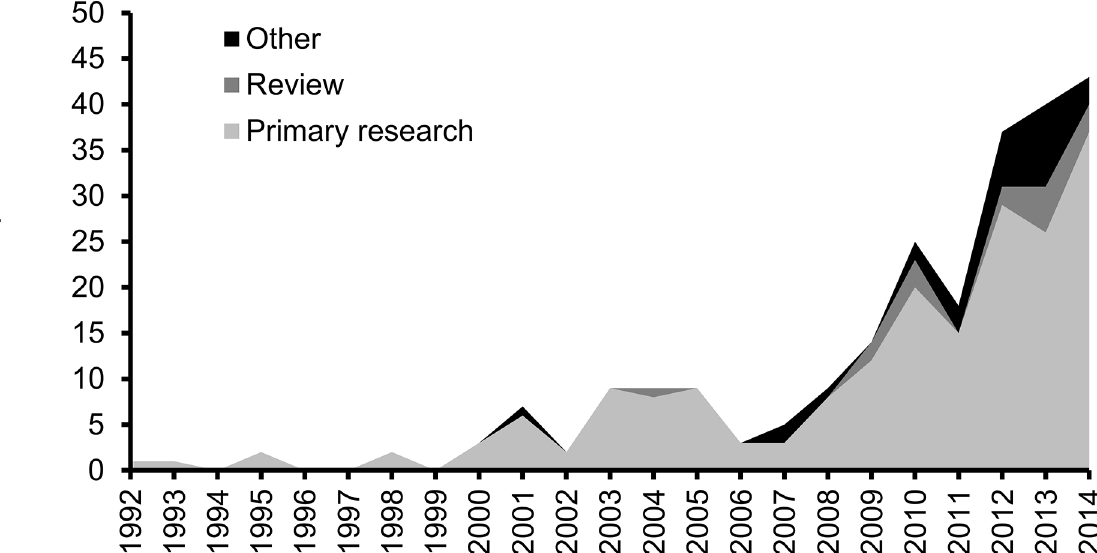
Fig 2. Development of research on the effect of neonicotinoids on bees over time. The single meta-analysis study was published in 2011 [12] and is not included in this figure. Data for 2015 (not complete; see text) included 20 primary research publications, 2 reviews and 6 other publications (not included in figure).